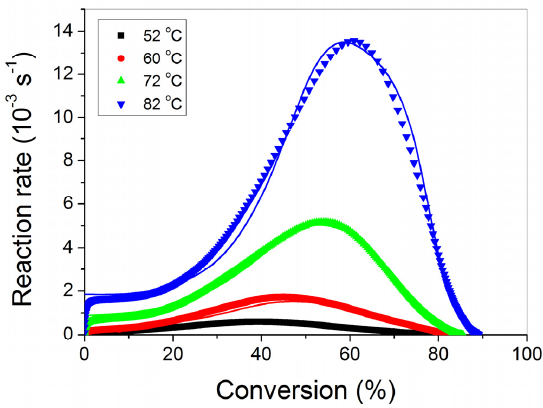
Figure 4. Comparison of the experimental and simulated rate curves for HEMA polymerization at different temperatures.